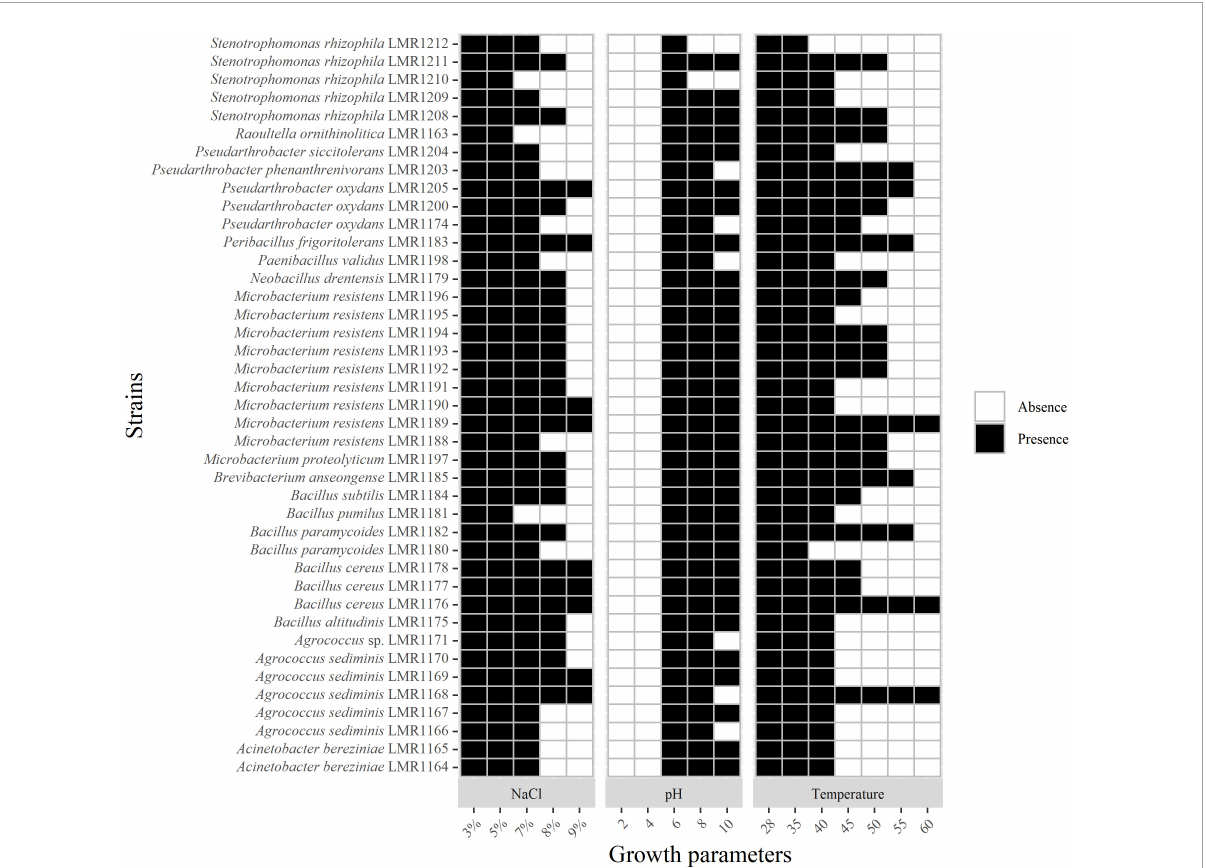
FIGURE2 Heatmap of the capacity of the 41 isolated strains to tolerate different concentrations of NaCl and different pH and temperature. Presence and absence indicate the presence or the absence of